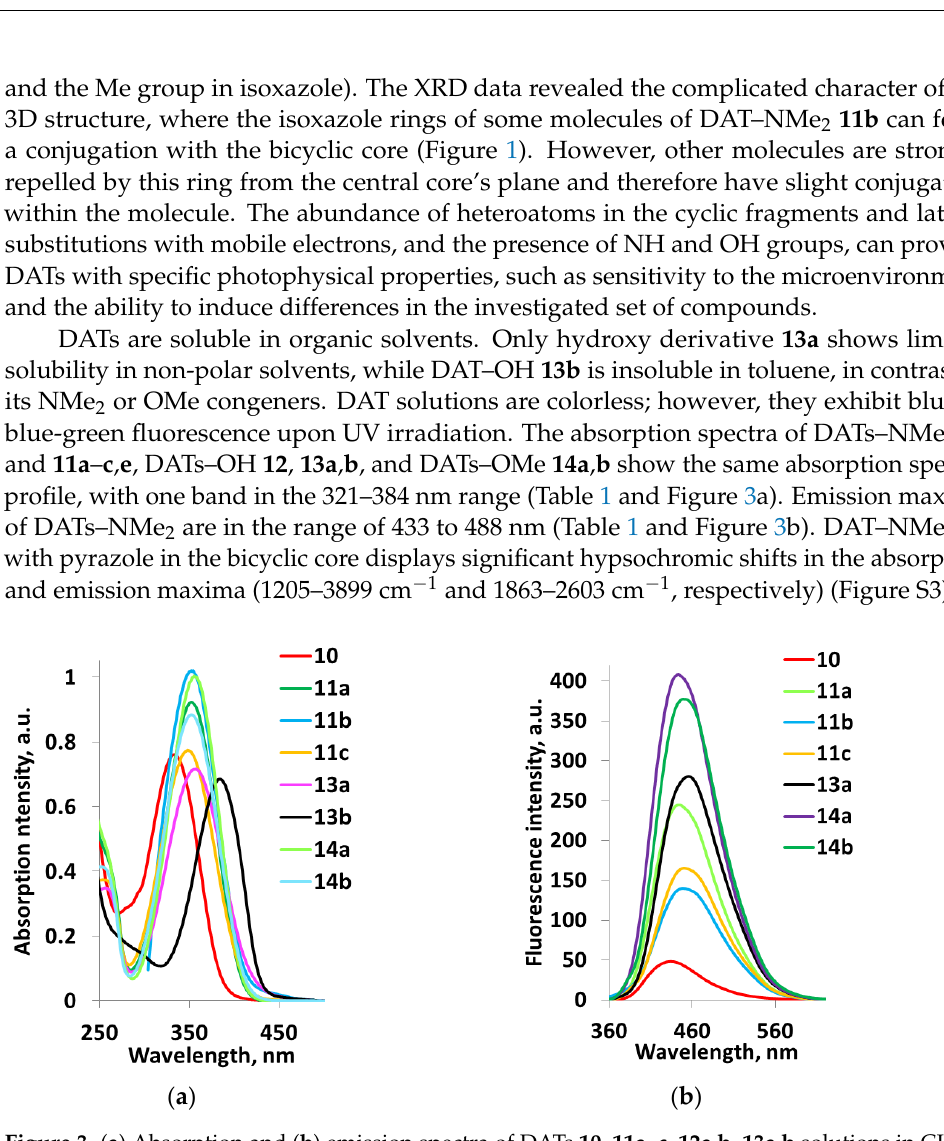
Figure 3. ( a ) Absorption and ( b ) emission spectra of DATs 10 , 11a – c , 12a , b , 13a , b solutions in CHCl 3 ( c = 5 × 10 −5 M for adsorption and c = 5 × 10 −6 M for emission).